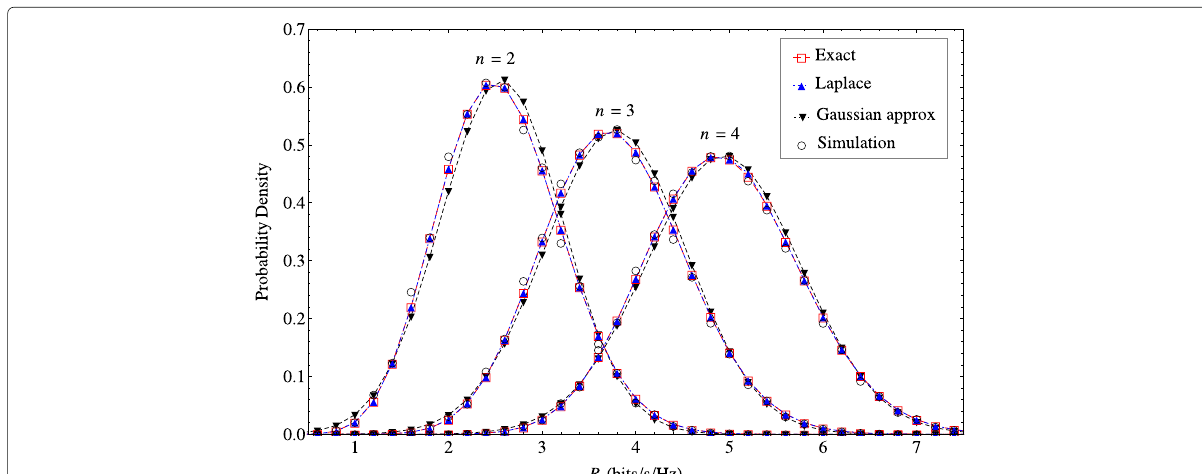
Fig. 5 Mutual information probability density for n = { 2,3,4 } , n A = 4, n B = 5, a = 1, and b = 1 / 3